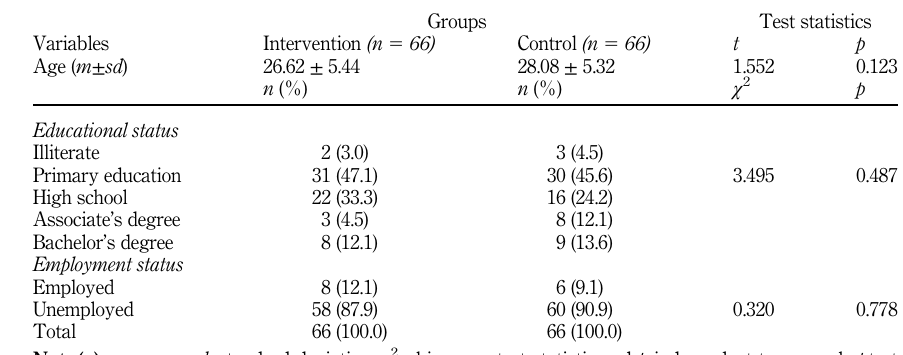
Table 1. Comparison of descriptive characteristics of the